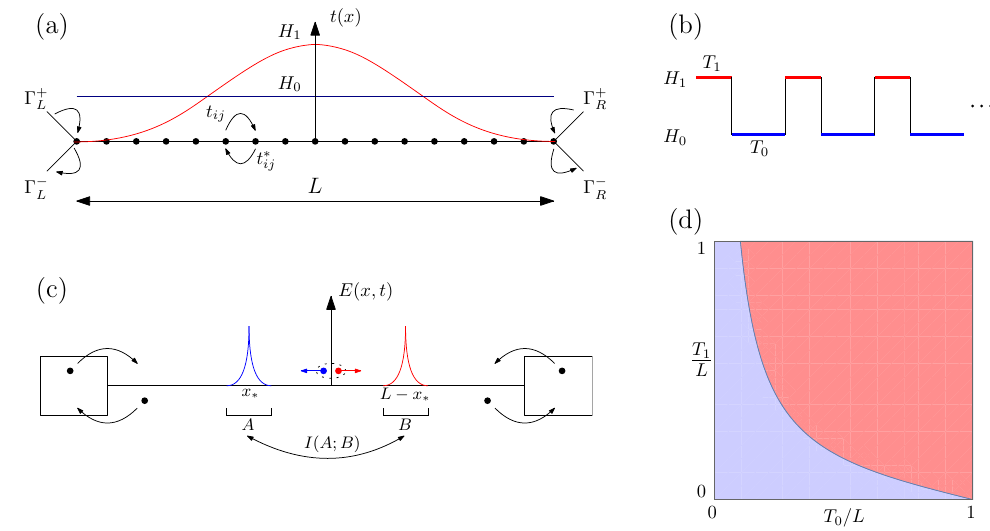
Figure 1: (a) Two Hamiltonians used to construct the Floquet drive: homogeneous Hamiltonian H and sine-square deformed Hamiltonian H on a free fermion chain 0 1 of length L , with dissipators placed at the boundaries of the chain and characterised by dissipation rates Γ ± . (b) Illustration of the two step drive H ( t ) between H and 0 L / R H . (c) Sketch of the emergent spatial structure in the energy density E ( x , t ) in the 1 heating phase, with two hotspots x ∗ and L − x ∗ , interpreted as emergent horizons in a stroboscopic curved space-time [ 39 ] . At each Floquet cycle entangled pairs of quasiparticles are created, which accumulate at each of the two peaks, leading to a linear growth of mutual information I ( A ; B ) between the two horizons. We want to understand the robustness of this phenomenology to the introduction of dissipa- tion and thermal initial states. (d) Phase diagram between heating and non-heating phases in the case without dissipation at zero